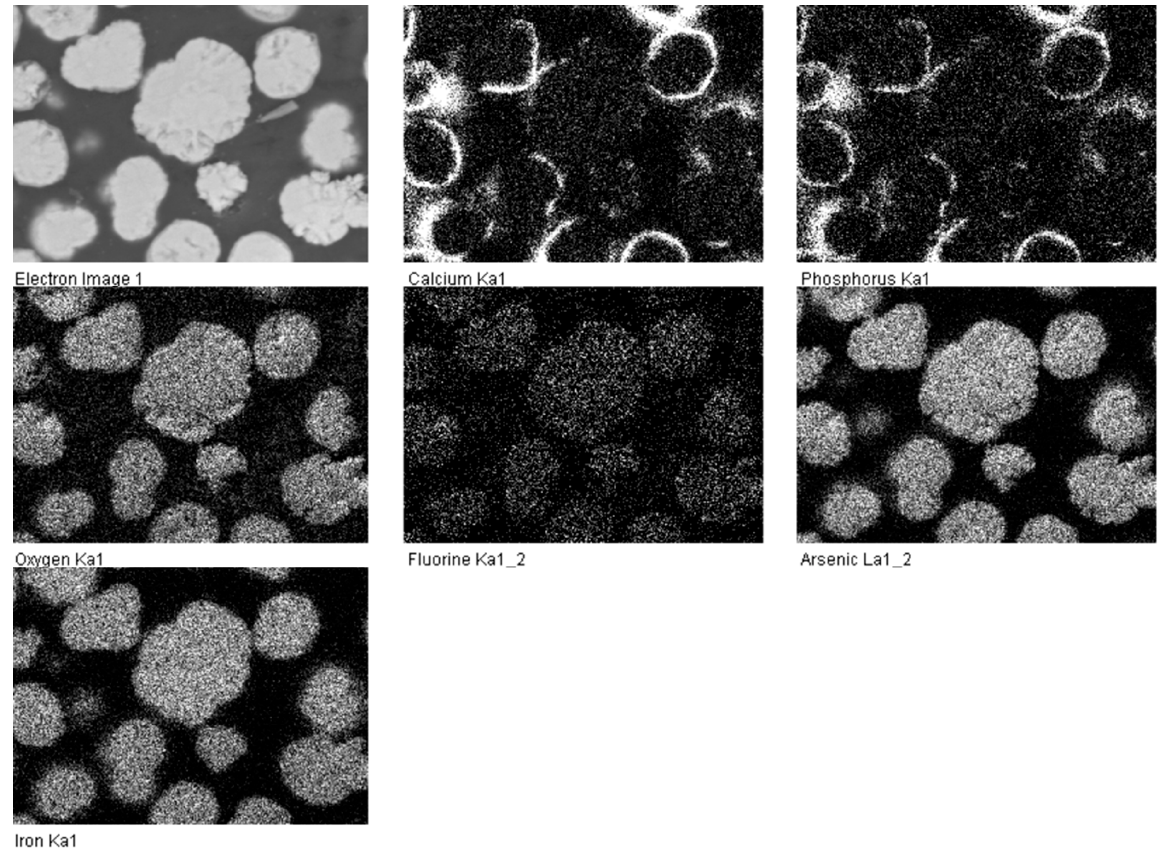
Figure 7. Backscattered electron image and elemental mapping of scorodite@FAP particles produced with the ENCH-E.